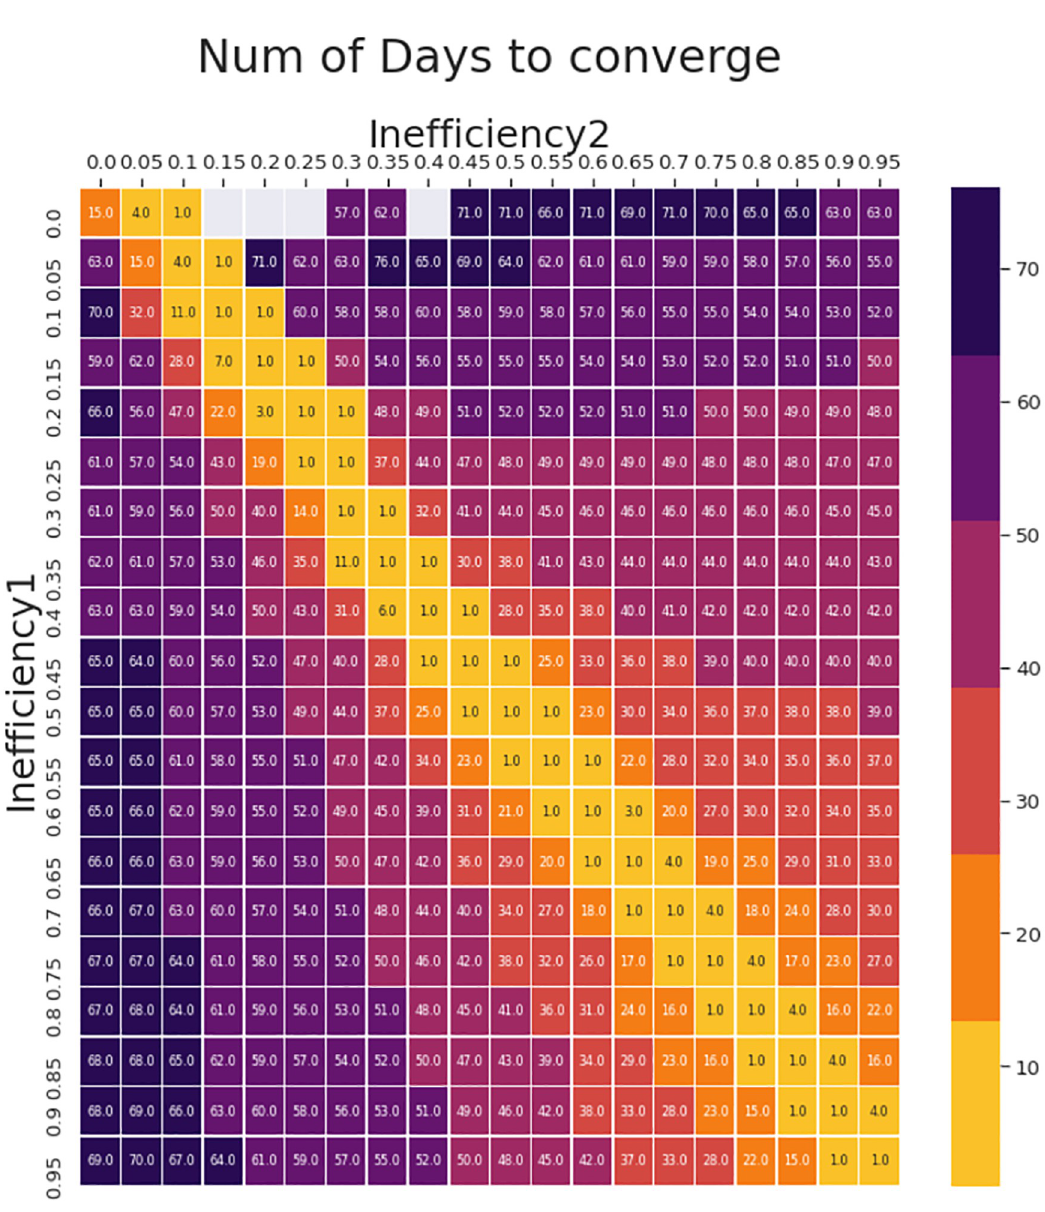
PLOS ONE | https://doi.org/10.1371/journal.pone.0283081 March 17,